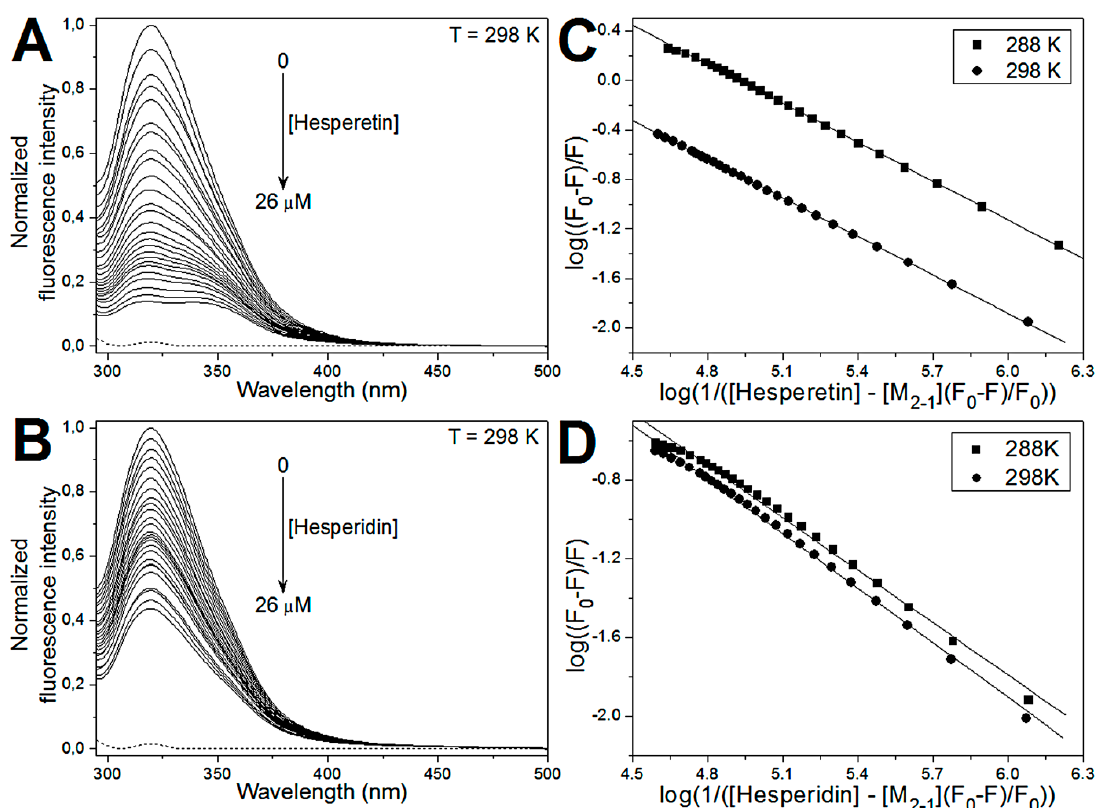
Figure 3. Emission spectra of human Respiratory Syncytial Virus (hRSV) M 2-1 protein in the absence and presence of ( A ) HST and ( B ) HSD at 298 K (25 °C). The concentration of M 2-1 protein was 6 µM and the concentration of the flavanones varied from 0 to 26 µM. The dotted line represents the buffer emission spectrum. The double-log plots for the interaction of the ( C ) HST and ( D ) HSD with the M 2-1 protein. The fluorescence experiments performed at 288 K are shown as squares and at 298 K are depicted as circles. The solid line represents the linear fitting.